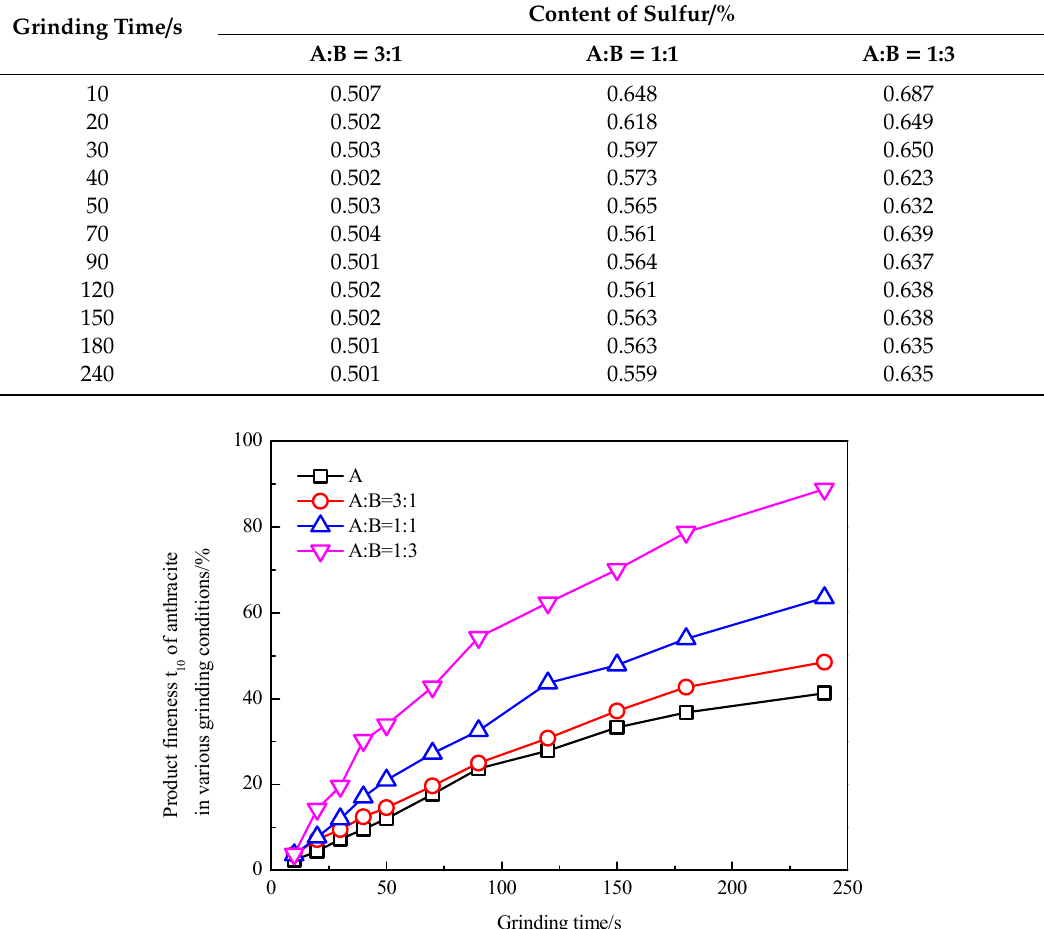
Figure 5. Product fineness t 10 of anthracite for various grinding conditions and times.